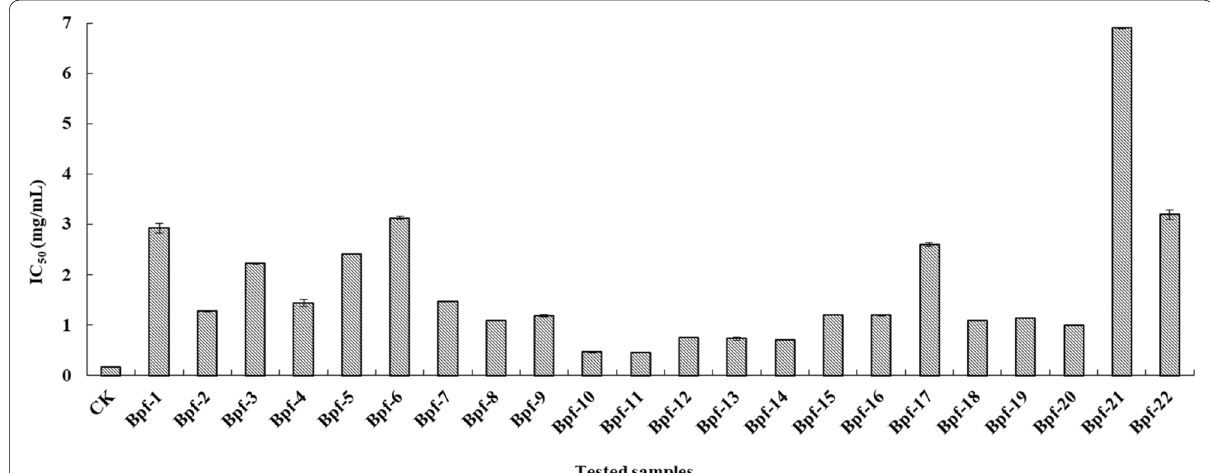
Fig. 2 Antioxidant activities of crude extracts of endophytic fungi isolated from B . polyandra